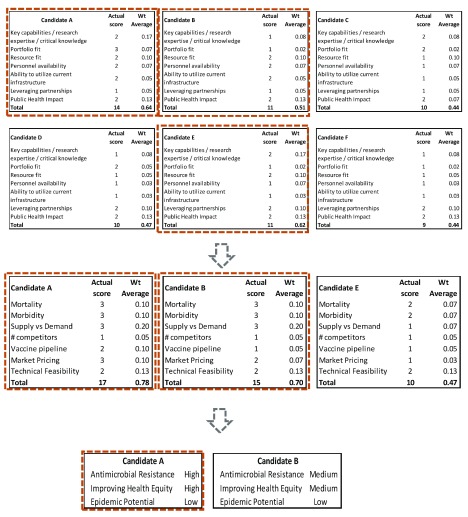
Logical Framework – Execution.